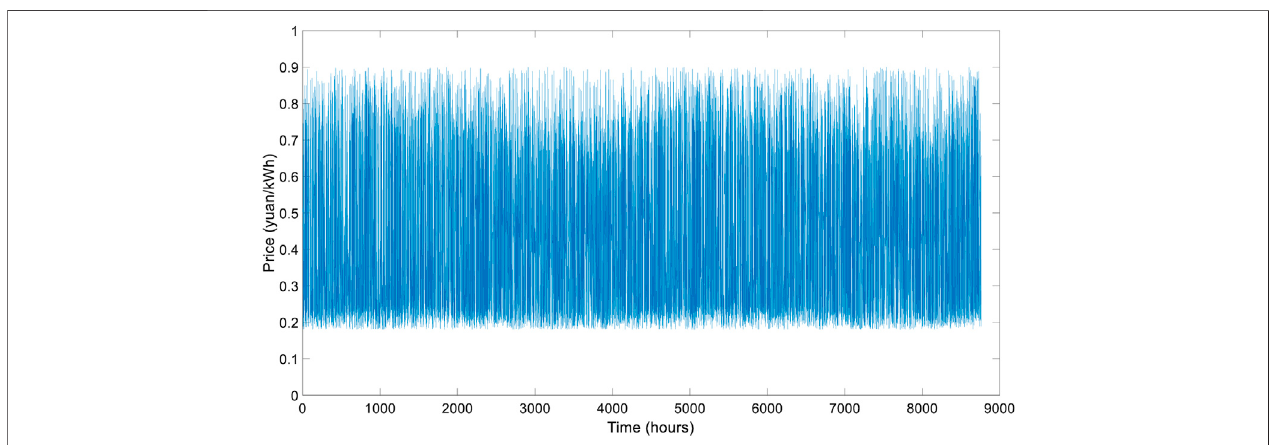
FIGURE 2 | Single simulation of electricity prices (for 1